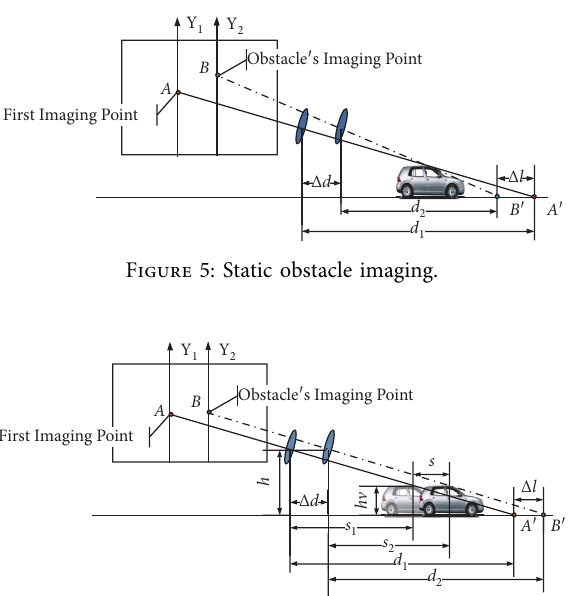
Figure 6: Moving obstacle imaging.